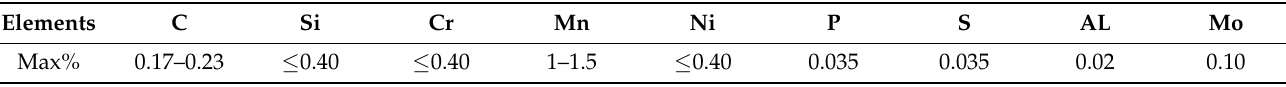
Table 1. Chemical properties of AISI 1522H